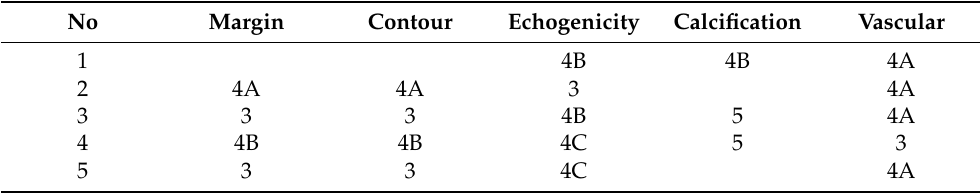
Table 3. Examples of translated clinical reports in TIRADS category.